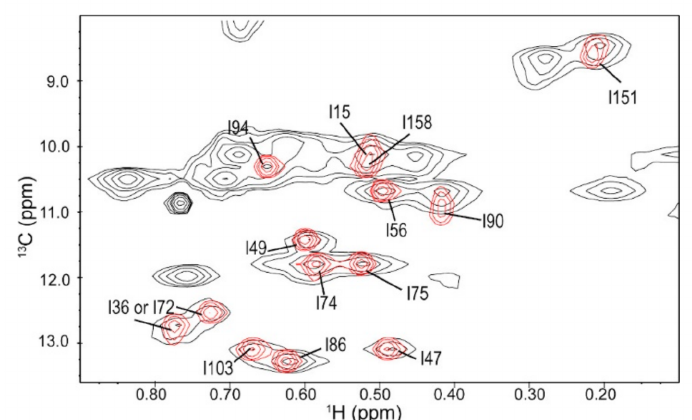
Figure 2. 1 H- 13 C heteronclear multiple quantum coherence (HMQC) Ile methyl NMR spectrum of 3C (red) and 3CD